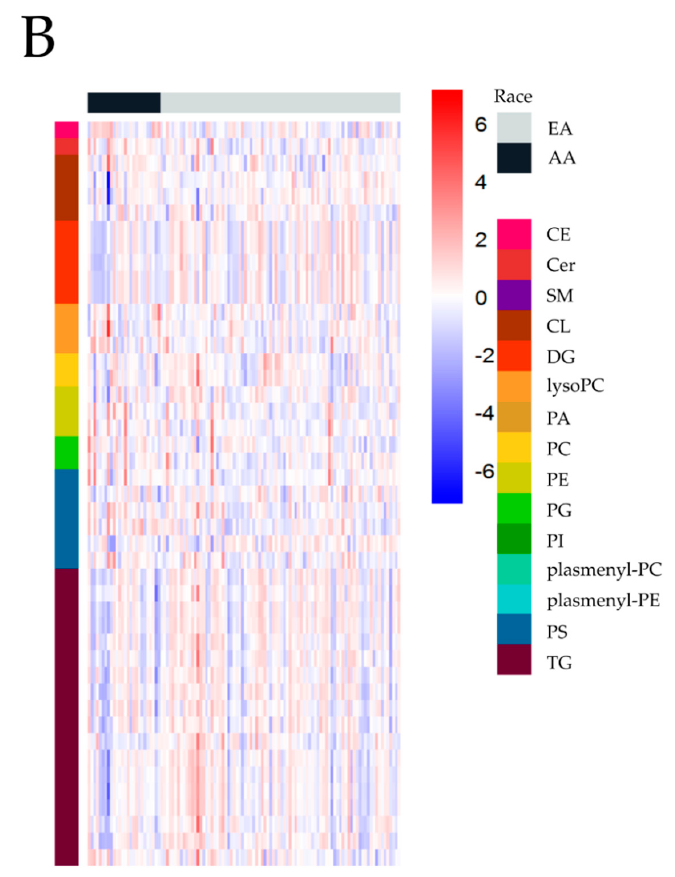
Figure 1. Lipidomic profiling of triple-negative subtype of breast cancer (TNBC) tumors reveals that changes in lipid metabolism are associated with tumor site and racial ancestry. ( A ) Pie chart depiction of the 684 lipids measured and lipid class representation. ( B ) Heatmap of differential lipids between African-American (AA) and European-American (EA) patients in TNBC tumor tissue (false discovery rate (FDR)-adjusted p value < 0.25).